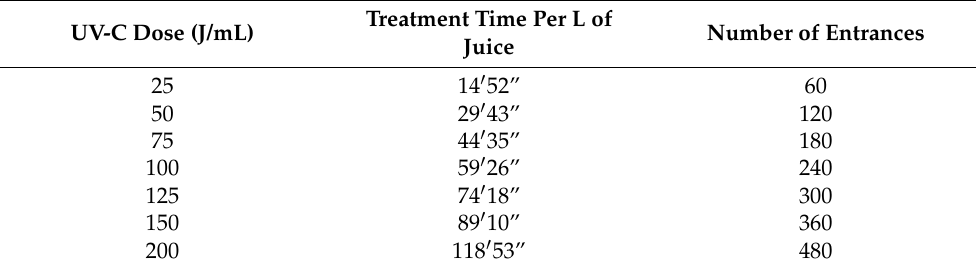
Table 1. Calculated treatment time in minutes and seconds, and the number of entrances per litre of apple juice through the UV-C reactor at the different doses. The pumping speed for all doses was 0.708